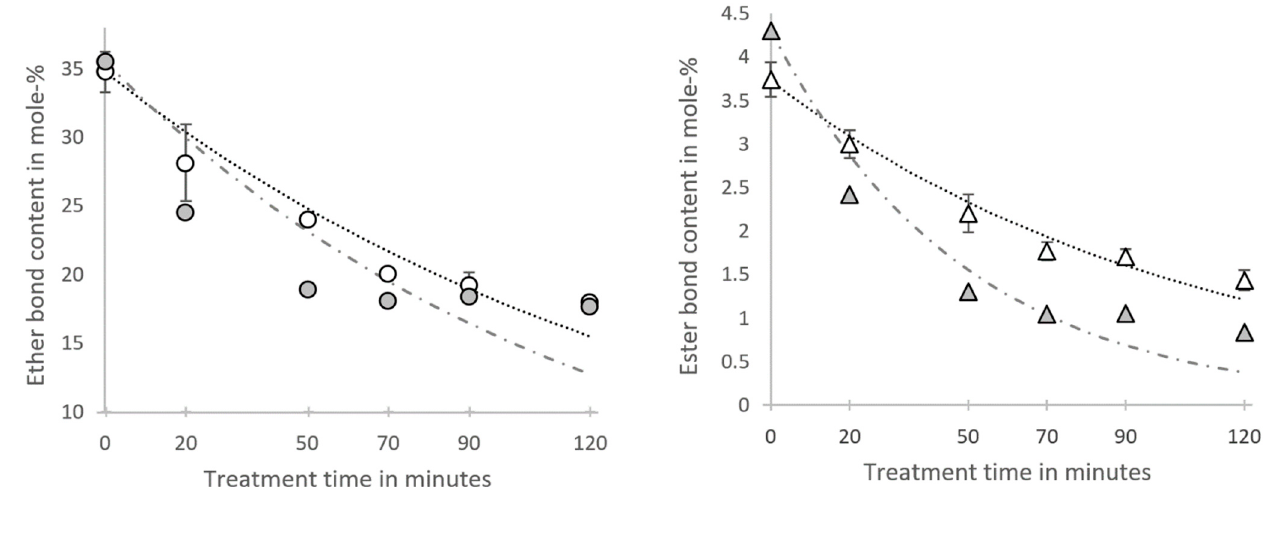
Figure 6. Content of ether linkages ( a ) and ester linkages ( b ) in raw digestate (filled in gray • ) and washed digestate (no filling ) as a function of hydrothermal treatment time. The values are based on the results from thioacidolysis (for ether bonds) and saponification (for ester bonds) as described in Section 2.3.3 and more detailed in Appendix B. The data were fitted to 1st order reaction kinetics using a dotted line to fit the data for washed digestate ( ) and a dashed line to fit the data for raw digestate ( ) and the resulting degradation rate constants are given below the diagrams. For the washed digestate, measurements were performed in duplicates from samples of one hydrothermally treated sample (error bars indicating the standard deviation). For the raw digestate, measurements were performed as single determinations.